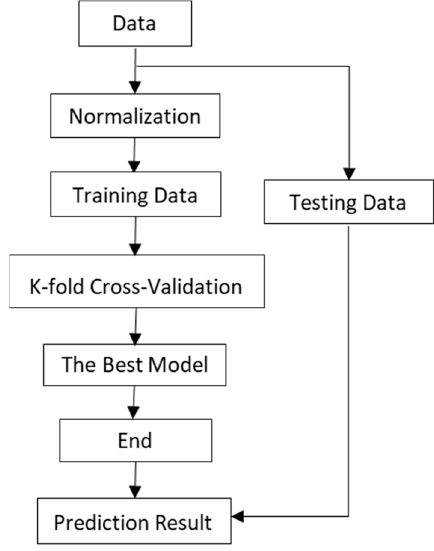
Figure 8. Methodology